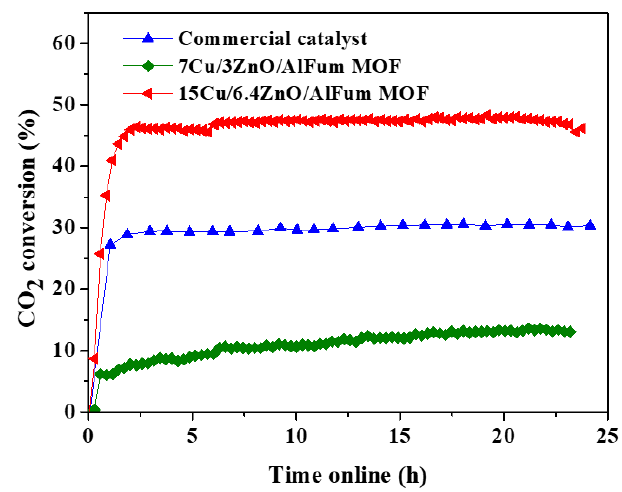
Figure 6. CO 2 conversions of the evaluated catalysts. Temperature = 230 °C; pressure = 50 bar; Q v,0 = 40 mL min −1 ; gas hourly space velocity = 10,000 h −1 ; H 2 /CO 2 = 3:1.